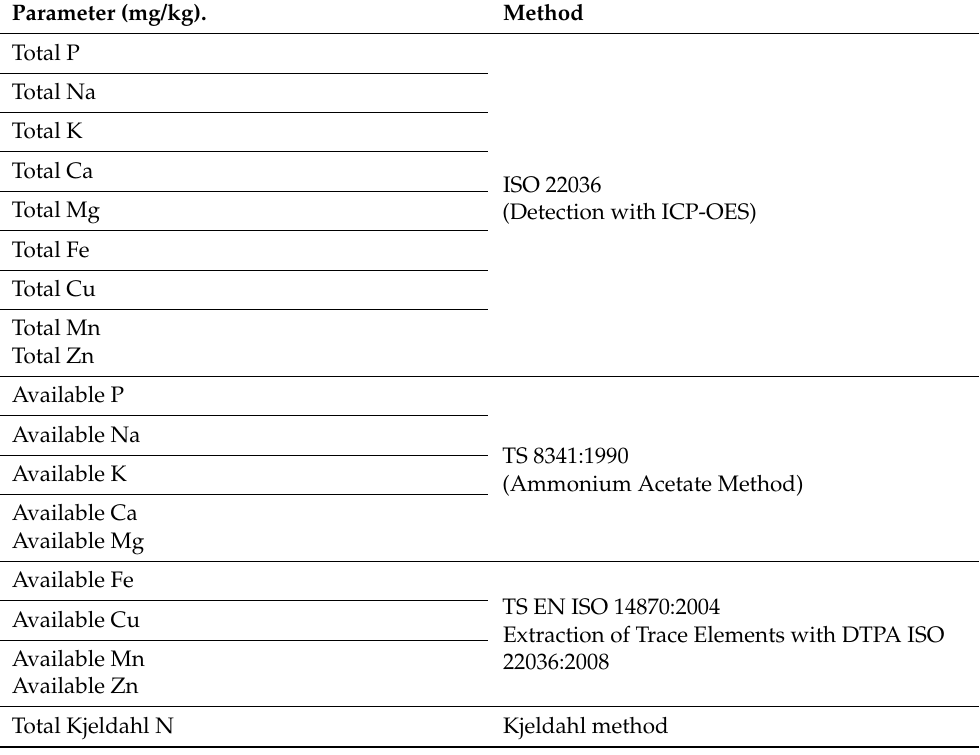
Table 1. Methods used for total and available plant nutrient determination in compost samples. Parameter